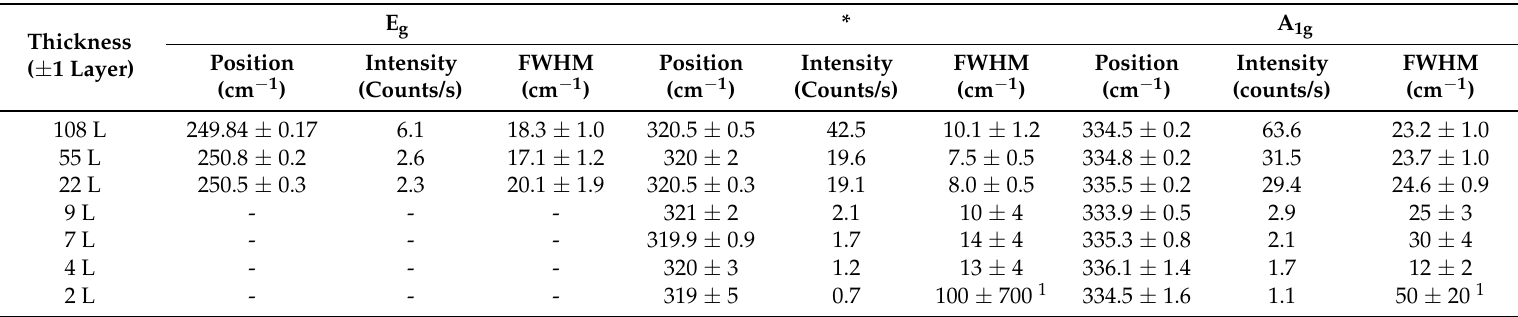
Table C2. Thickness dependence of the fitted parameters (position, intensity, and FWHM) of the E g and A 1g modes obtained from the Raman spectra for ZrS 2 on a Si/Au substrate ( λ = 532 nm) presented in Figure